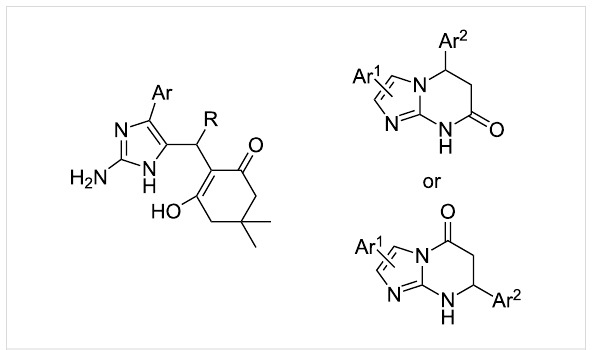
Figure 2: The Knoevenagel–Michael adduct [24] and expected prod- ucts.